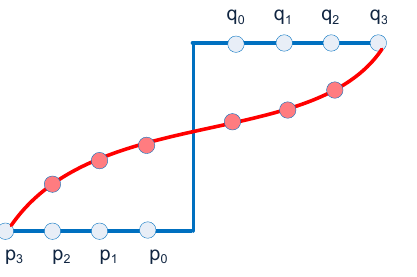
Figure 1. Variation of pixel intensities between block boundaries.